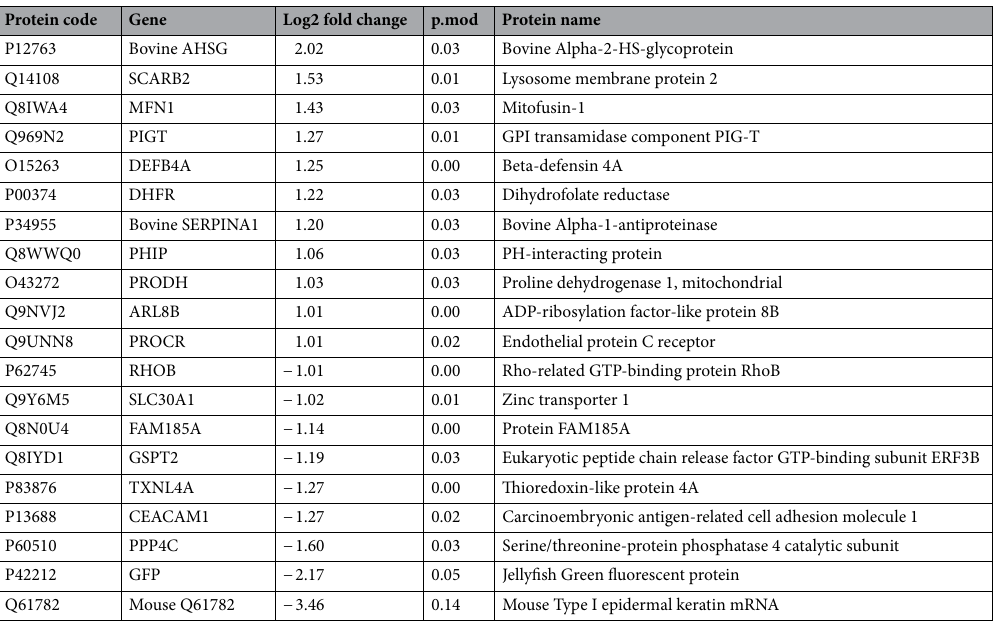
Table 2. Proteomic analysis of HBD2-stimulated HaCaT cells. HaCaT cell monolayers were treated with 0.5 μg/ml HBD2, or vehicle control, in serum free media for 48 h before the cells were washed rigorously with PBS and scraped from the well surface. Cell pellets were washed an additional three times with PBS in suspension. Dry cell pellets were stored at -80 °C prior to analysis; n = 5 per condition. Log fold changes and P values generated using LIMMA pathway 43 . Table shows proteins with the greatest differences in detection levels between control and HBD2 treated conditions, largest to smallest with Uniprot protein code, gene code, fold change, p.mod value, protein name and brief description of function. Protein descriptions made using UniProt database information 46